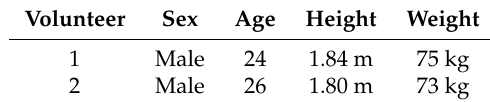
Table 2. Volunteer data for Sensorized Tip Laboratory